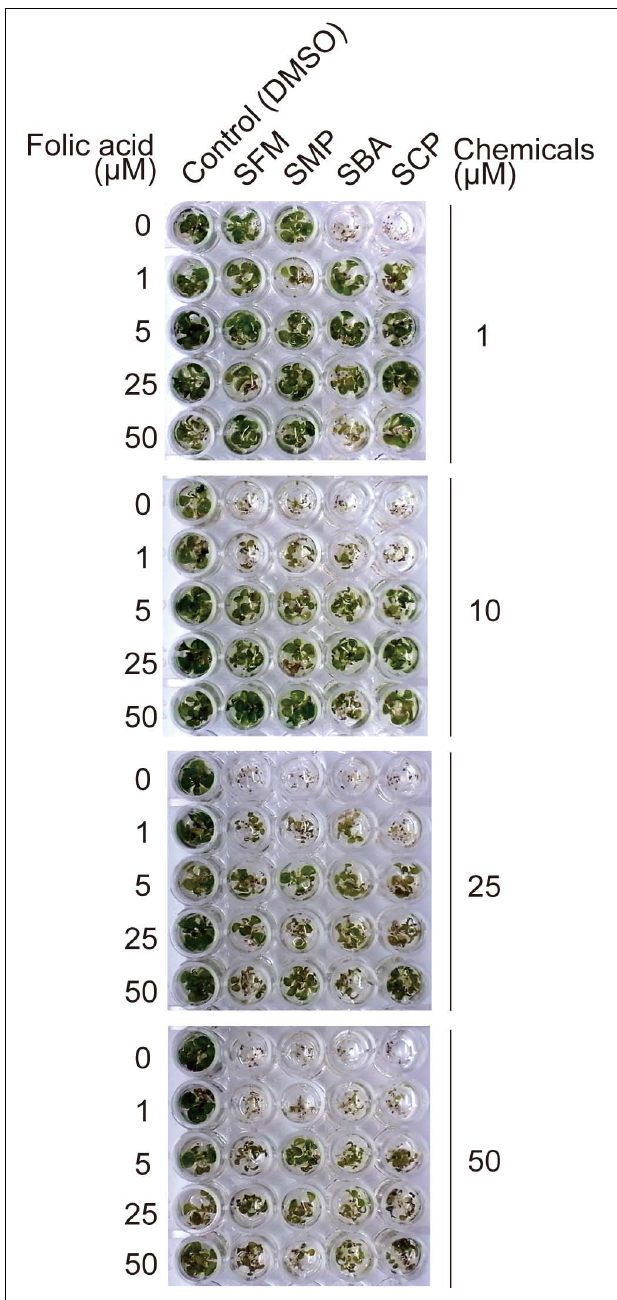
FIGURE 8 |The effect of the sulfonamides on germination of Arabidopsis thaliana . Arabidopsis seeds were dispensed into each well of a 96-well plate, and liquid media containing each sulfonamide and folic acid at the indicated concentrations were applied, followed by incubation under long-day conditions at 22 ◦ C. Photographs were taken after 2 weeks.These data are representative of two independent replicates with similar